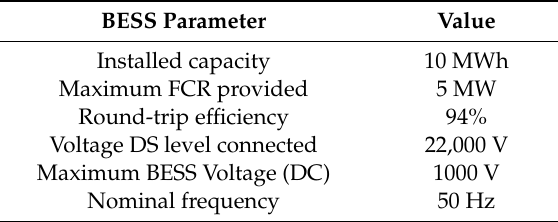
Table 5. Basic technical parameters of the battery energy system storage